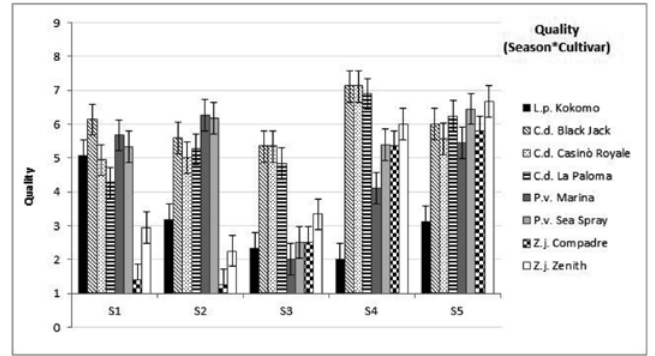
Fig. 1 - Global quality of the species/cultivars under investigation dur- ing the trial period (assessment with 1-9 scale). Bars = standard error. L.p. = Lolium perenne, C.d. = Cynodon dactylon , P.v. = Paspalum vaginatum, Z.j. = Zoysia japonica